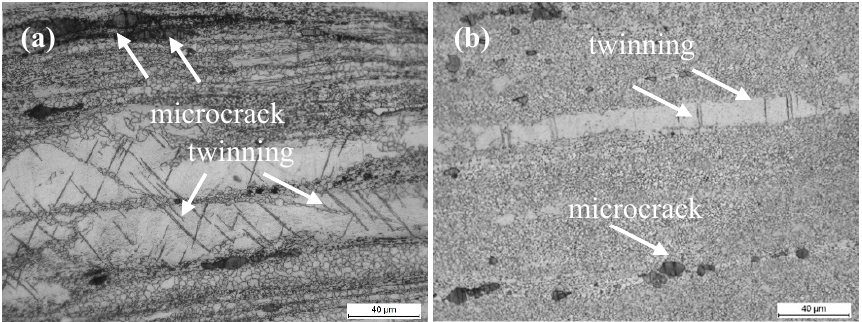
Figure 7. OM from gage sections of fractured tensile samples for the extruded TZA822 alloys in different states: ( a ) without T4 and ( b ) with T4.